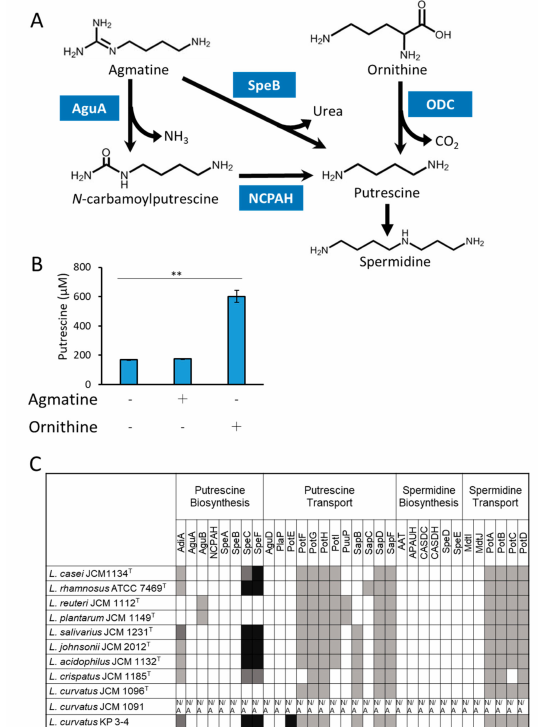
Figure 5. Prediction of the putrescine biosynthetic pathway by L. curvatus KP 3-4. ( A ) Known putrescine biosynthetic pathways in bacteria. The abbreviations used are as follows: AguA, agma- tine deiminase; SpeB, agmatine ureohydrolase; NCPAH, N -carbamoylputrescine amidohydrolase; ODC, ornithine decarboxylase. ( B ) L. curvatus KP 3-4 was cultured in MRS or MRS with added arginine or ornithine anaerobically for 48 h at 37 ◦ C and the amount of putrescine in the culture supernatant was analyzed by HPLC. Data represent means ± standard deviation from biological replicates ( n = 3). Asterisks indicate statistical significance (** p < 0.01, Dunnett’s test with MRS as control). ( C ) Conservation analysis of polyamine synthesis and transport genes in lactic acid bacteria. The results shown are based on the tblastn analysis of the genome of the newly constructed L. cur- vatus KP 3-4 genome and genomes in the NCBI database (https://blast.ncbi.nlm.nih.gov/Blast.cgi (accessed on 16 May 2021)). Contig information for L. curvatus JCM1091 was not available in the NCBI database, and it is shown by N/A. AdiA, arginine decarboxylase; AguA, Agmatine deiminase; AguB, (AguB is NCPAH, putrescine carbamoyltransferase is PtcA); NCPAH, N -carbamoylputrescine amidohydrolase; SpeA, arginine decarboxylase; SpeB, agmatinase; SpeC, ornithine decarboxylase; SpeF, ornithine decarboxylase; AguD, agmatine:putrescine antiporter; PlaP, putrescine importer; PotE, putrescine:ornithine antiporter; PotF, putrescine ABC transporter periplasmic binding protein; PotG, ATP binding protein of putrescine ABC transporter PotFGHI; PotH, permease of putrescine ABC transporter PotFGHI; PotI, permease of putrescine ABC transporter PotFGHI; PuuP, putrescine importer; SapB, transmembrane protein of putrescine exporter SapBCDF; SapC, transmembrane protein of putrescine exporter SapBCDF; SapD, ATP binding protein of putrescine exporter SapBCDF; SapF, ATP binding protein of putrescine exporter SapBCDF; AAT, agmatine aminopropyltrans- ferase; APAUH, aminopropylagmatine ureohydrolase; CASDC, carboxyspermidine decarboxylase; CASDH, carboxyspermidine dehydrogenase; SpeD, S -adenosylmethionine decarboxylase, proen- zyme; SpeE, spermidine synthase; MdtI, multidrug efflux system transporter; MdtJ, multidrug efflux system transporter; PotA, ATP binding protein of spermidine/putrescine ABC transporter PotABCD; PotB, permease of spermidine/putrescine ABC transporter PotABCD; PotC, permease of spermi- dine/putrescine ABC transporter PotABCD; PotD, spermidine/putrescine ABC transporter. The color of each column indicates the score from the Protein BLAST analysis: (black) >500 bits, (dark gray) 500–300 bits, (light gray) 300–100 bits, and (white) <100 bits,